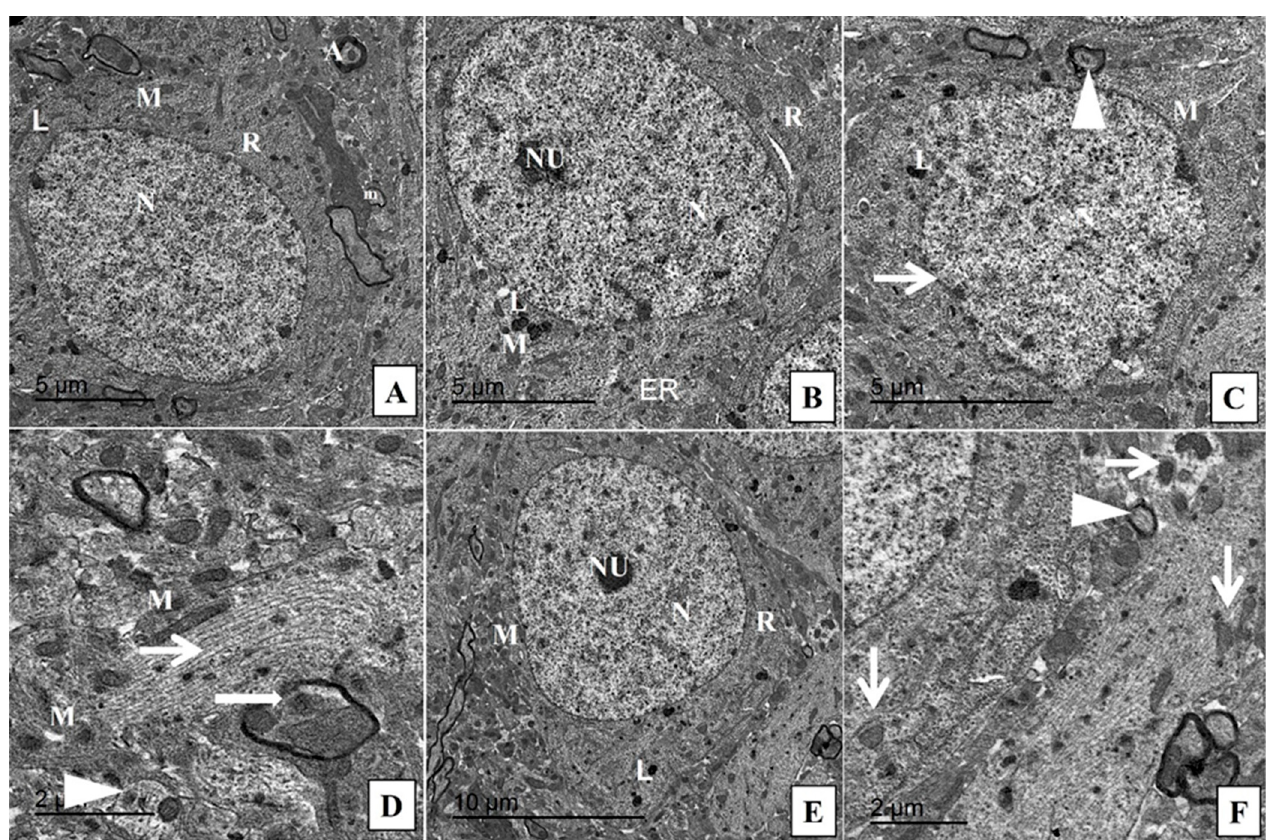
Figure 4. Transmission electron micrographs of hippocampus from different groups. ( A ) Control group showing the normal structure of the neuron with normal nucleus (N) and cytoplasm containing mitochondria (M), ribosome (R) with surrounding healthy myelinated axons wrapped by myelin (A) and axonal mitochondria (m). ( B ) CeNPs group showing the normal structure of the neuronal cells with intact nuclear envelope, distinct nucleoli, normal cytoplasmic organelles (mitochondria (M), ribosomes (R), lysosomes (L) and endoplasmic reticulum (ER)). ( C ) DOX group showing enlarged nucleus with blebs of nuclear envelope (thin arrow), loss of nucleolus and few irregular shaped mitochondria (M) with minimal degenerating sheaths surrounding a degenerated axon (ar ‐ rowhead). ( D ) DOX group showing complete loss of myelin sheath (arrowhead), other area showing intact axon with gradual loss of myelin (thick arrow) beside dilated microtubules (thin arrow) in ‐ tercalated with few irregular shaped mitochondria (M). ( E , F ) Treated group DOX + CeNPs showing the normal architecture of nucleus (N) with prominent nucleoli (NU) and most cytoplasmic orga ‐ nelles (mitochondria (M), lysosome (L) and ribosome (R) within the neurological cell. ( F ) Higher power showing with minimal mitochondrial membrane losses (thin arrows) either inside and around the neuronal cell with minimally affected sheath (arrowhead). Scale bar = 5 μ m ( A – C ), 2 μ m ( D , F ), 10 μ m ( E ).